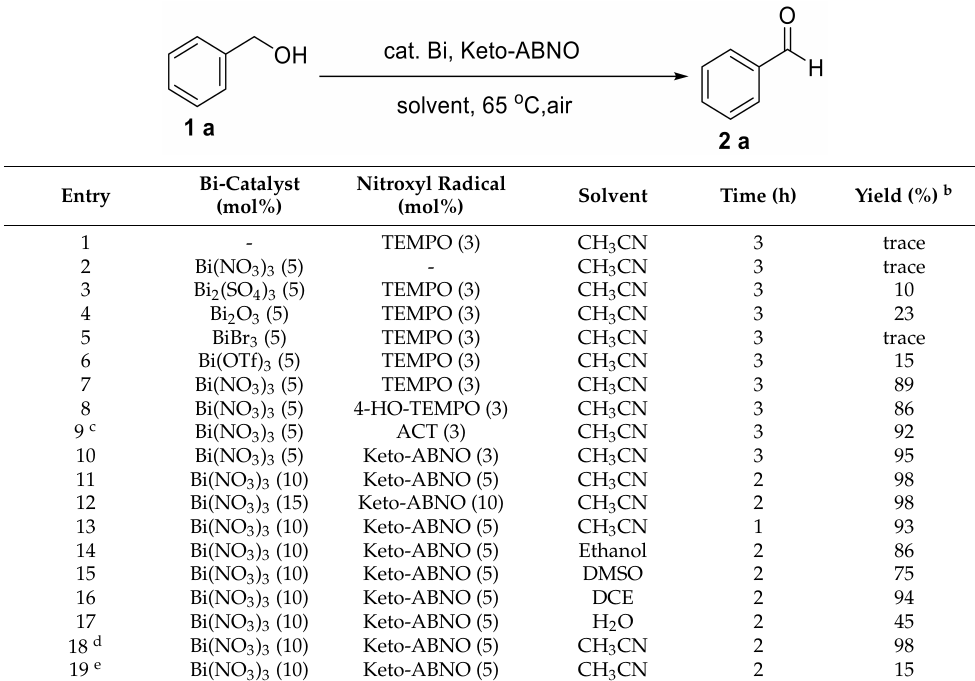
Table 1. Optimization of reaction conditions a